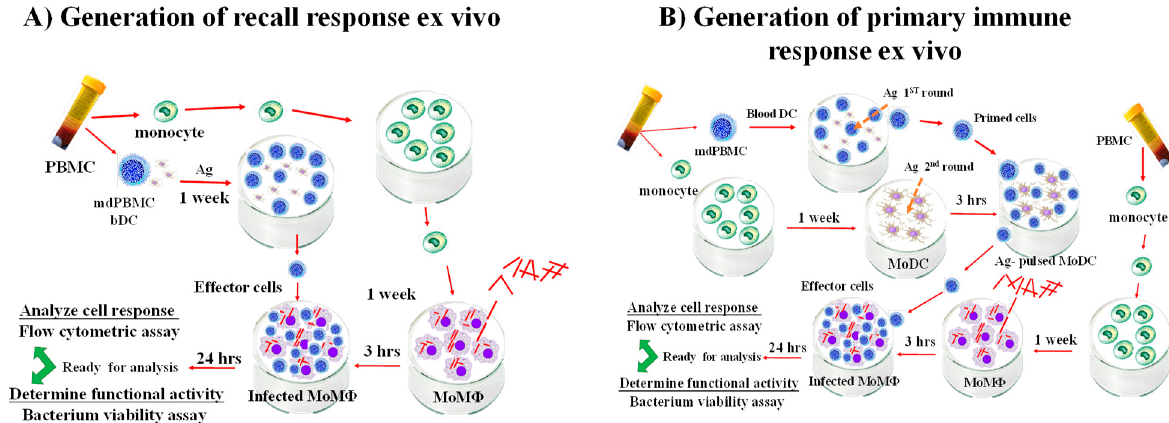
Figure 2. Flow diagrams illustrating the platforms developed to study the recall and primary cellular immune responses to live and peptide-based vaccines ex vivo. ( A ) For analysis of the recall response, PBMC from vaccinated cattle are separated into monocytes and mononuclear cells containing CD4 and CD8 T cells, γδ T cells, and CD209 positive blood dendritic cells (bDC). The bDC are stimulated directly without separation and cultured for a week. The monocytes are cultured in parallel for a week to generate monocyte-derived macrophage (MoM Φ ) target cells. At one week, the MoM Φ are infected with Map or BCG fpr 3 h, washed to remove free bacteria, and then overlayed with stimulated or unstimulated monocyte depleted PBMC (mdPBMC). At 24 h post-stimulation, one set of cells are processed for flow cytometric analysis. The remaining set of cells are processed to isolate DNA from bacteria to determine the extent of killing mediated by CD8 cytotoxic T cells using a bacterium viability assay. ( B ) For analysis of the primary immune response, PBMC from naïve cattle are separated into mdPBMC containing bDC and monocytes. The mdPBMC are stimulated with Ag for one week. The monocytes are cultured with granulocyte/monocyte-stimulating factor (GMCSF) and interluekin 4 (IL-4) for six days to generate monocyte-derived DC (MoDC). The Ag-primed MoDC are mixed with the Ag-stimulated mdPBMC and cultured for an additional six days. At six days, monocytes are isolated from blood and cultured to generate MoM Φ target cells. As described for analysis of the recall response, sets of doubly stimulated mdPBMC are co-cultured with infected target cells. After 24 h incubation, the culures are processed to analyze the CD8 CTL response and extent of killing of bacteria by CD8 CTL [46].